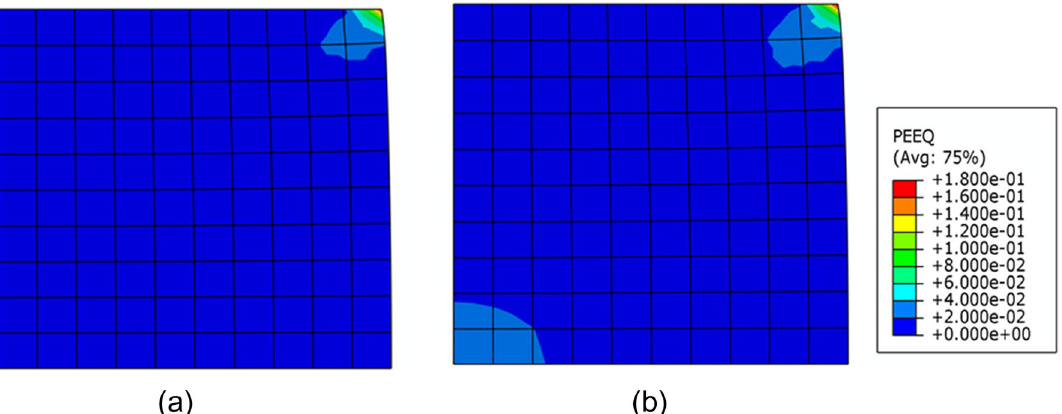
Figure 17. The equivalent plastic strains of the block after loading corresponding to ( a ) the upper bound and ( b ) the lower bound in Fig. by the target model. The influence of material uncertainty on the structure plastic deformation is successfully identified by the HSGPR model. Data availability The raw/processed data required to reproduce these findings cannot be shared at this time due to technical or time limitations. However, these data will be shared upon request to the corresponding author.